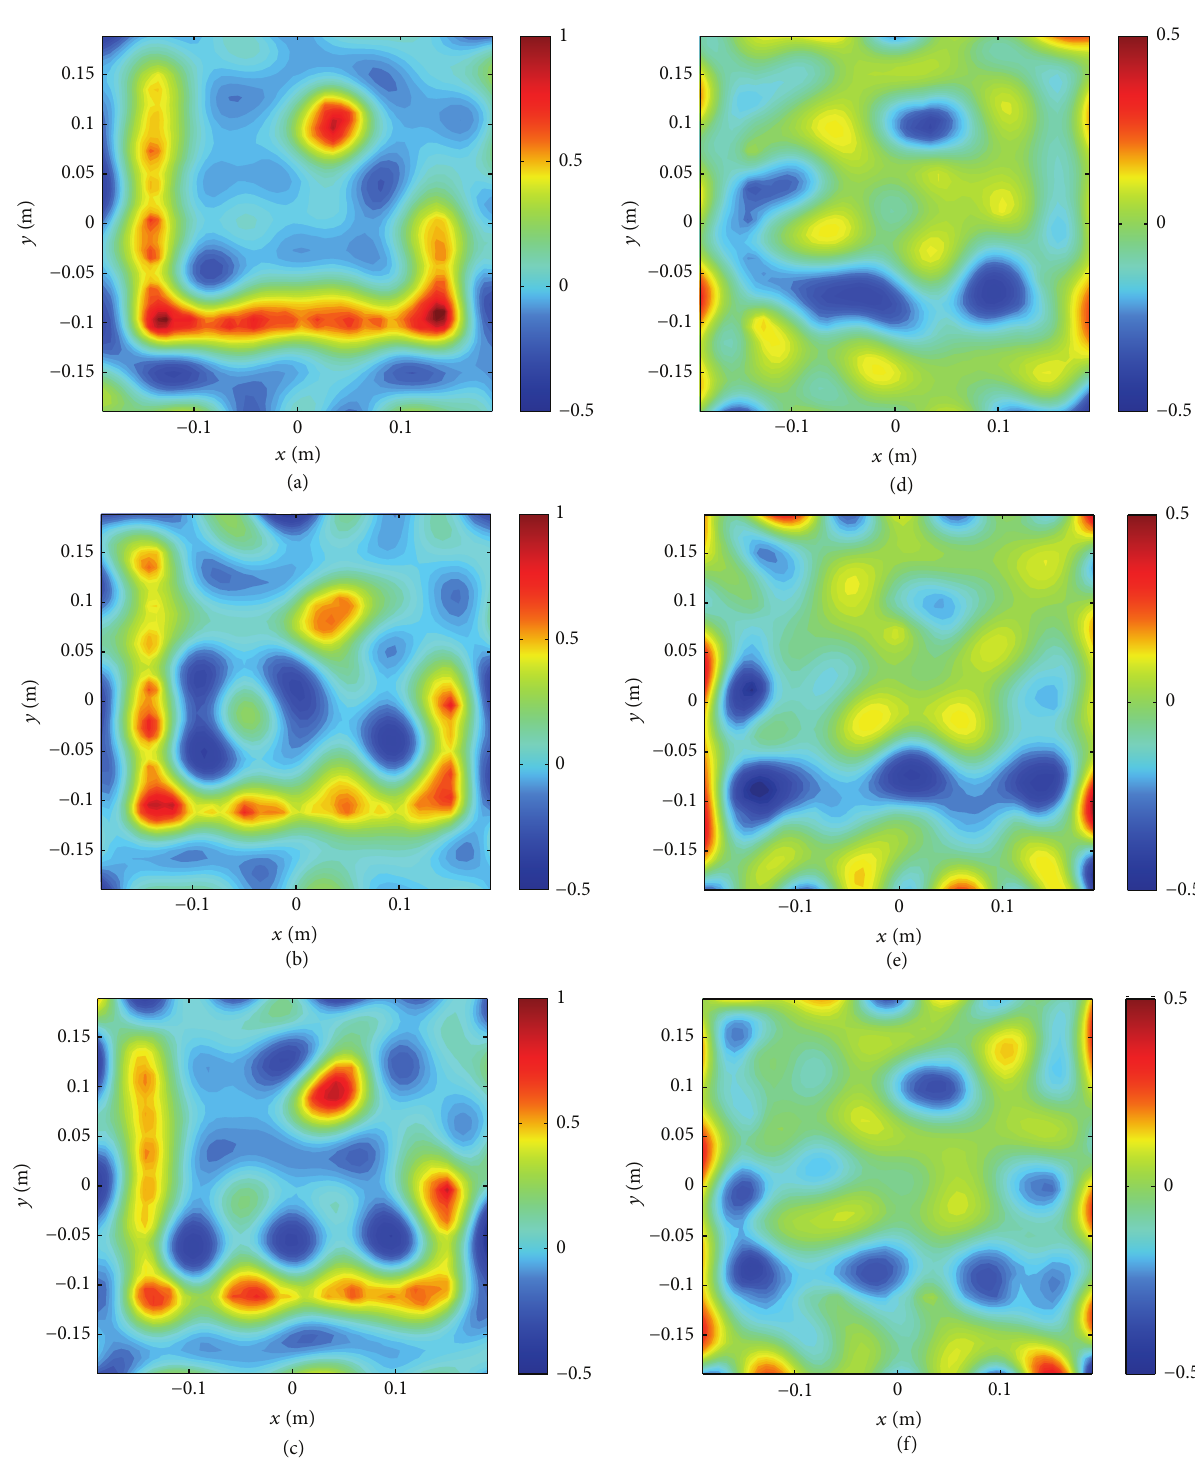
Figure 11: Example 2: QLSM reconstructions by using measurement configuration A. ((a), (d)) Real and imaginary parts of retrieved profiles in a circular scanner; ((b), (e)) real and imaginary parts of retrieved profiles in a square scanner; ((c), (f)) real and imaginary parts of retrieved profiles in a triangular